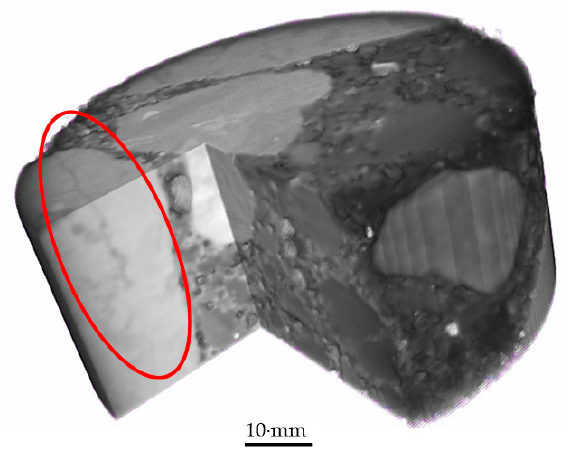
Figure 9. The 2D observation of a microcrack on an aggregate in one of the silane samples (yellow lines show the cutoff region in the 3D image shown in Figure 10).